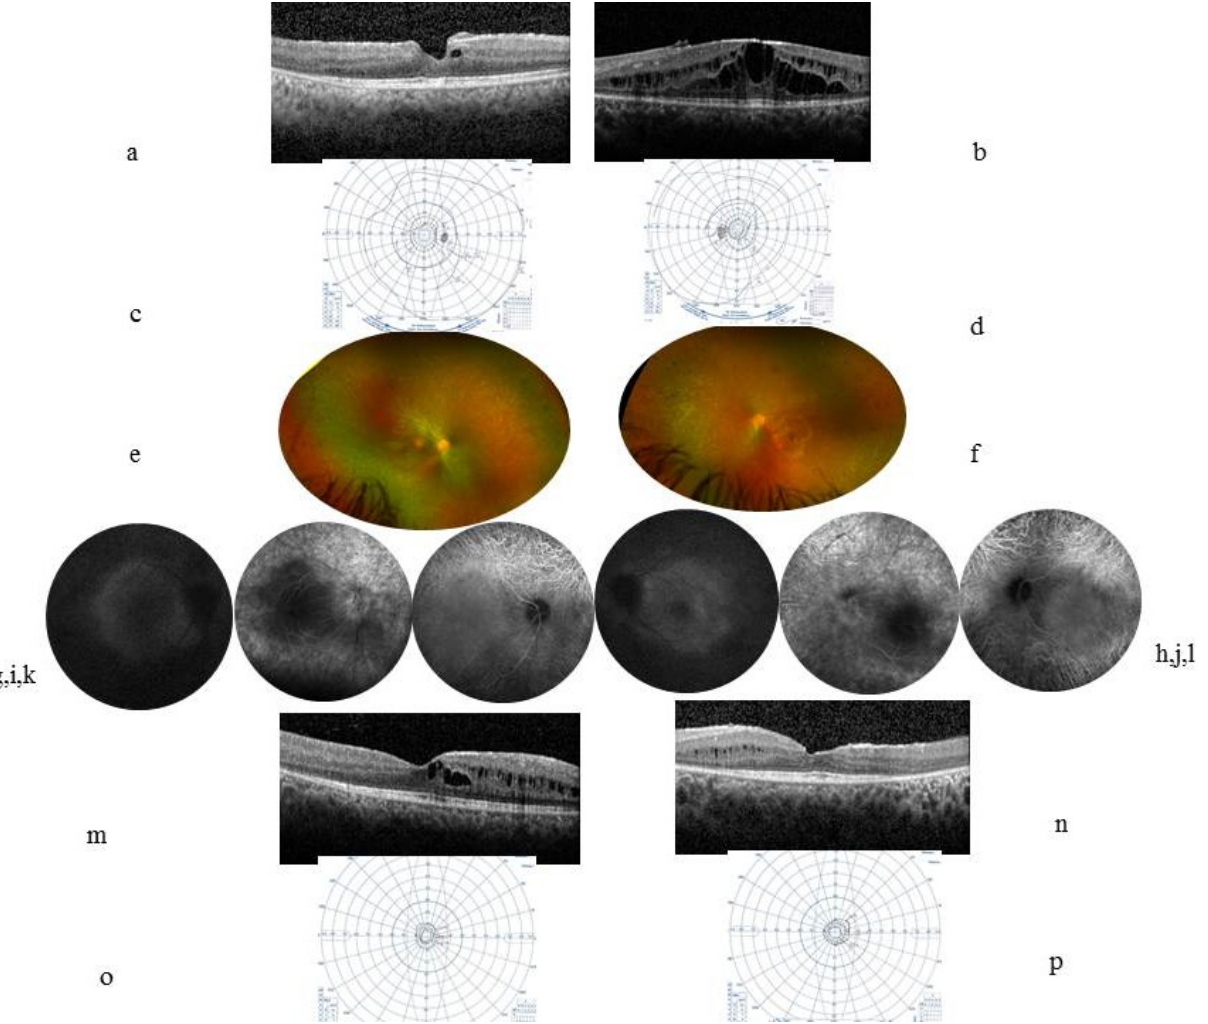
Figure 2. Case 2. At inclusion, a 13-year-old boy’s ( a ) (RE) ( b ) (LE) horizontal central macular OCT showed ME with a CFT at 344 µm in the RE and 467 µm in the LE. ( c ) (RE) ( d ) (LE) VF Goldmann was relatively preserved. Five years later, the VA was 20/25 in the RE and 20/40 in the LE. ( e ) (RE) ( f ) (LE) color fundus photographs showed small vessels and a pale papilla and a whitish annular scale bar ×10 perifoveal ring that corresponded to the hyperautofluorescent annular ring in autofluorescence pictures ( g , h ). ( i ) (RE) ( j ) (LE) FA showed macular and papillary leakage. ( k ) (RE) ( l ) (LE) ICGA showed visible choroidal vessels in the periphery. ( m ) (RE) ( n ) (LE) OCT showed persistent cysts that are mainly located within the internal nuclear layer and disappearance of the external layers including the ellipsoid and external nuclear layers at 1000 µm from the center; the RNFL thickness was stable, at 95 µm in the RE and 109 µm in the LE. ( o ) (RE) ( p ) (LE) tubular narrowing VF.